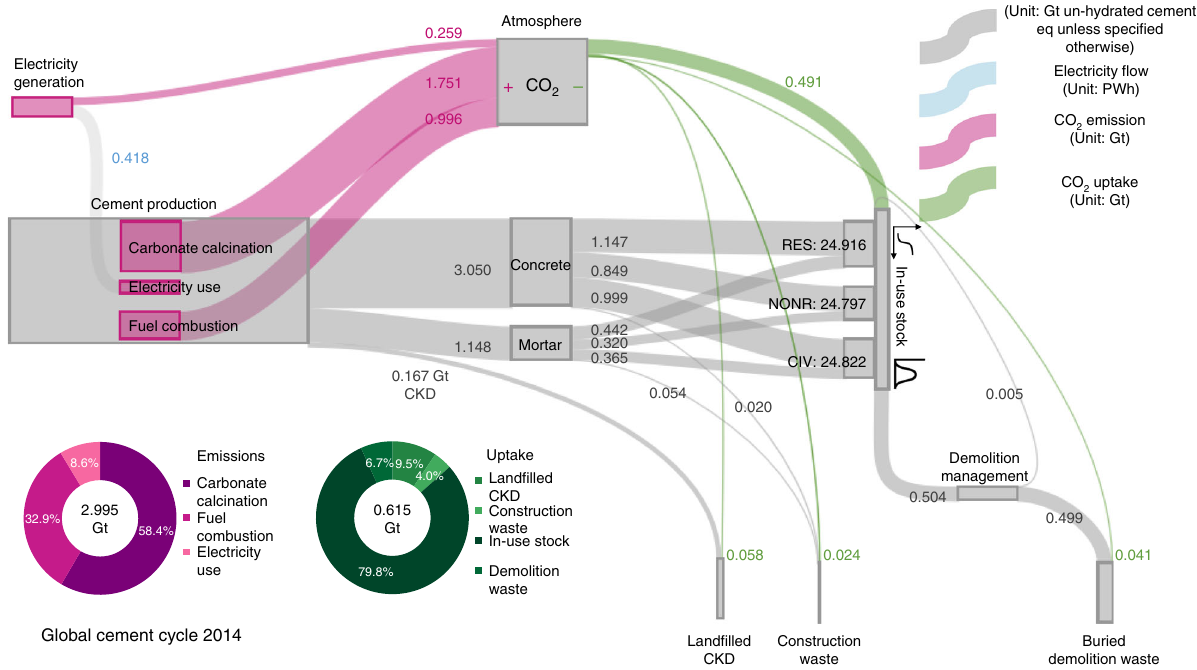
Fig. 1 Global cement cycle in 2014. The term cement most commonly refers to hydraulic (chie fl y Portland) cement 56 . All stocks and fl ows of cement- related materials are herein expressed in un-hydrated cement equivalent and excluding inert materials that are used as aggregate in concrete and mortar. Percentages may not add up to 100% due to rounding. RES residential buildings, NONR non-residential buildings, CIV civil engineering, CKD cement kiln